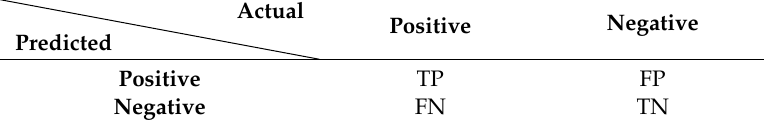
Table 1. Definitions of true positive (TP), false positive (FP), true negative (TN) and false negative (FN).